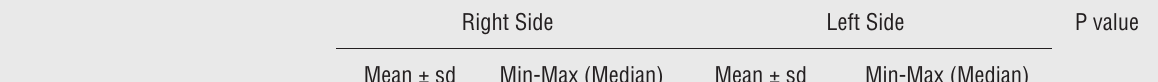
Table 2 - Comparison of challenging right and left laparoscopic adrenalectomy